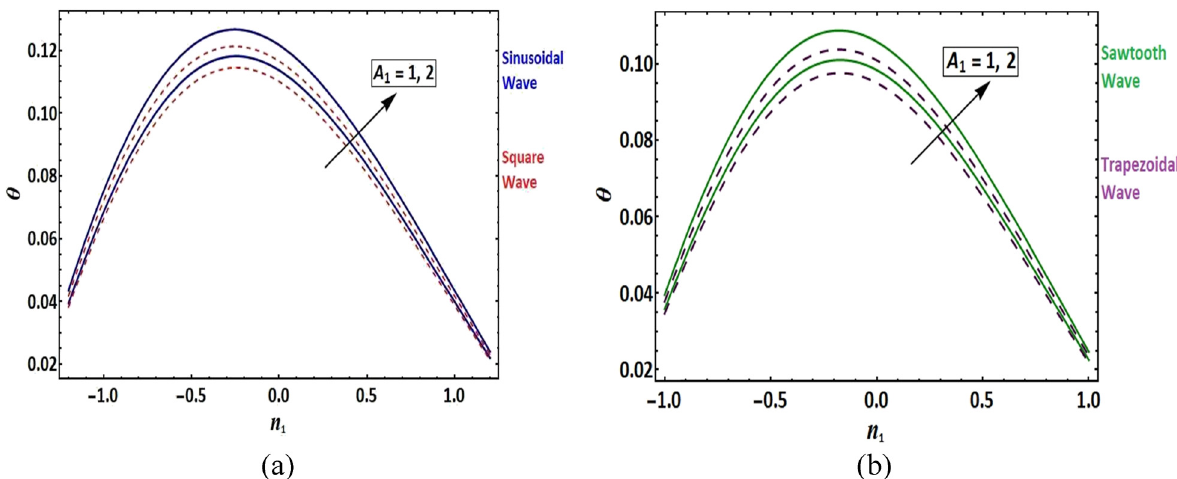
= 0.1,Sr = 0.5 A = 1,Br = 0.5, K = 2, K = 3, ϵ 0.2 = ,Gr = 0.4, B 4 3 3 1